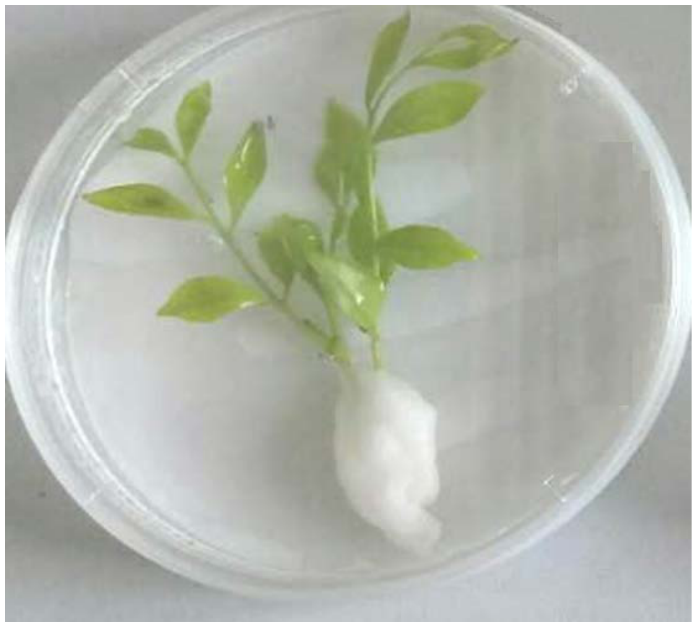
Figure 1. Murraya paniculata leaf petioles covered with a piece of sterile cotton in a sterile plastic Petri dish used for inoculation of D. citri with Cja Apopka 97 strain. Mated gravid female D. citri (100) were released into the center of new mesh cages. Females were permitted to oviposit (for 24 h) before adults were removed, as described above. The eggs were allowed to develop into third or fourth instar nymphs.